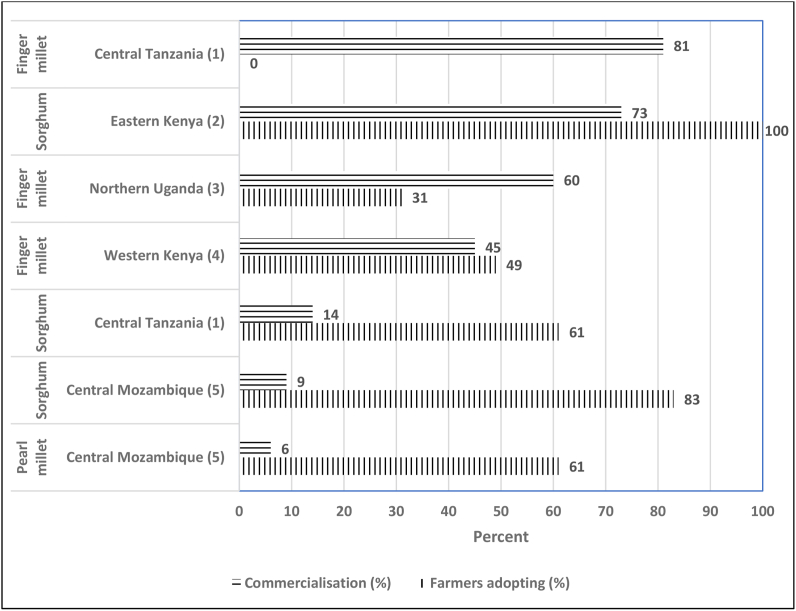
Commercialization and adoption of improved varieties (%).Sources:1.Schipmann et al. (2013).2Orr et al. (2013).3Mwema et al. (2017).4Handschuch (2014).5Tsusaka et al. (2015).